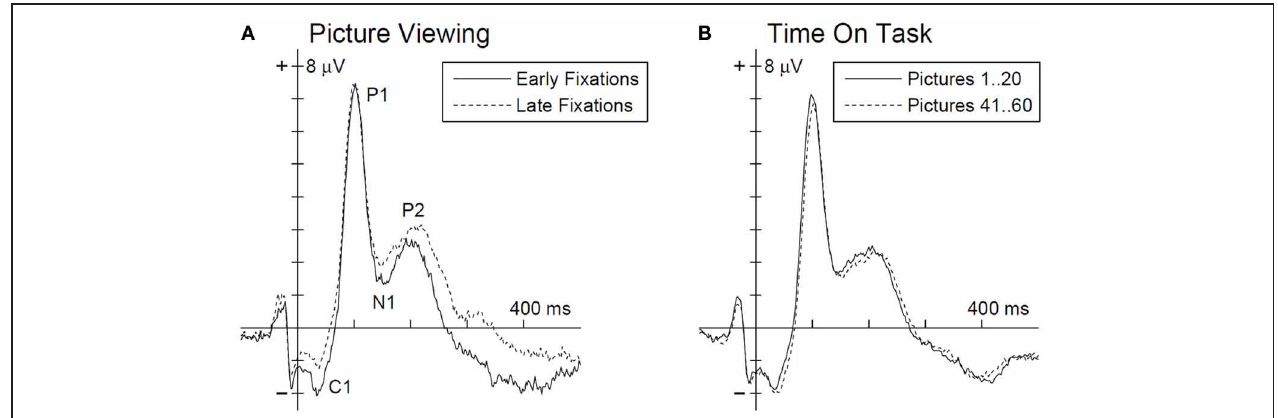
FIGURE 2 | Grand average EFRP for an occipito-parietal electrode cluster (PO3, POz, and PO4) for the analysis of picture viewing time (A) and time on task influences (B). Ordinate axis denotes the fixation onset. EFRP components of interest are annotated in panel (A) .